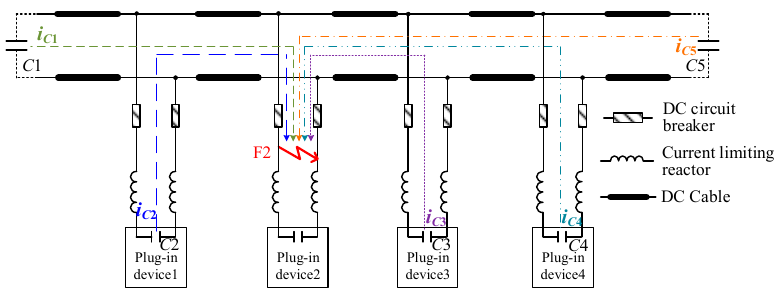
Figure 11. When F2 pole-to-pole fault occurs in plug-in device 2, other devices discharge to the fault point.